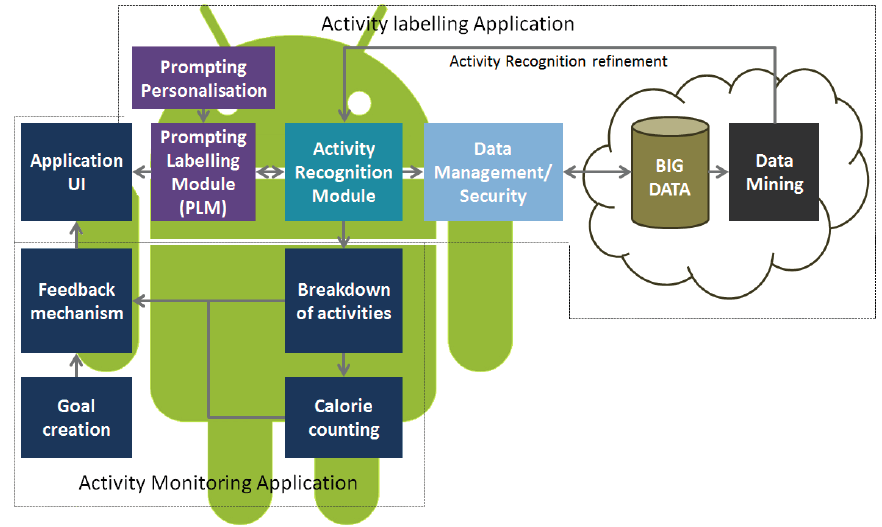
Figure 2. Overview of personalized mobile application for prompt labeling. The prompted labeling module sits on top of an existing AR module and periodically prompts users to label their activity. The architecture includes mobile services to support the secure transmission and processing of data in addition to the collection of other sensory data available from the mobile